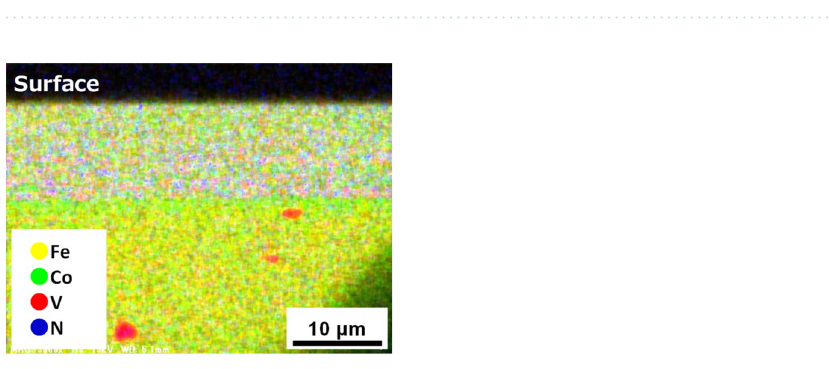
Figure 2. Sample preparation process (rolling and ammonia-gas-nitriding method).